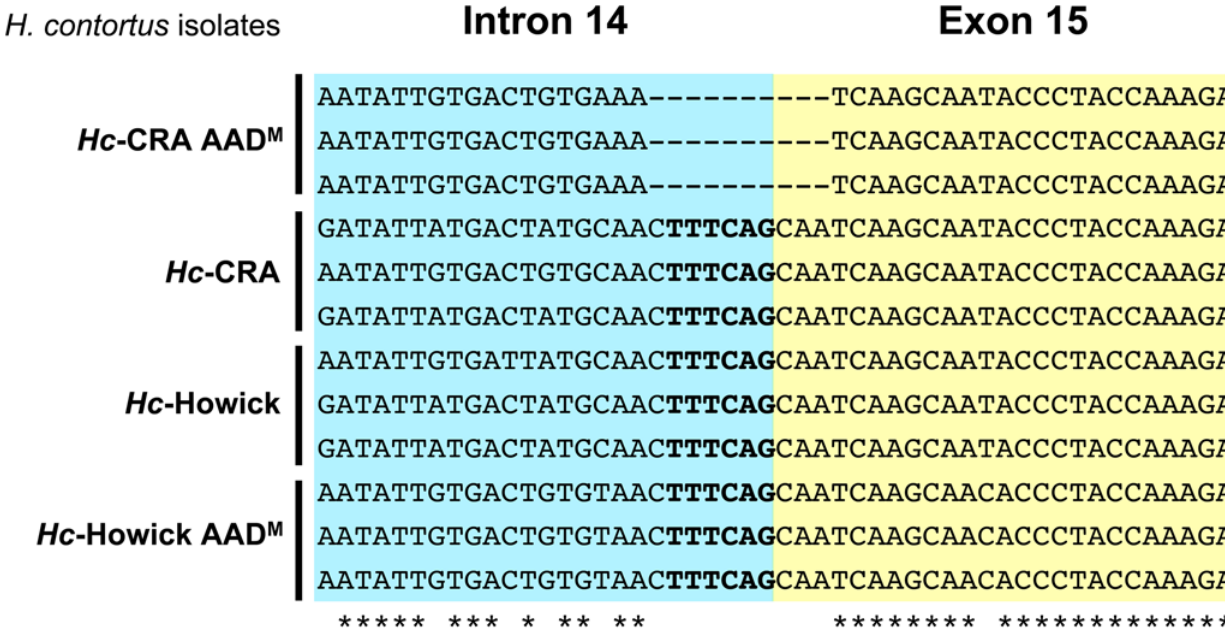
Figure 5. Hc -CRA AAD M mutants lack the splice acceptor site of intron 14. Sequencing of PCR products amplified from genomic DNA revealed a 10 bp deletion in the Hc -CRA AAD M mutant that encompasses the predicted splice acceptor site (bold). The blue box corresponds to the end of intron 14 and the yellow box to the start of exon 15. Asterisks denote bases identical throughout all 12 sequenced clones.